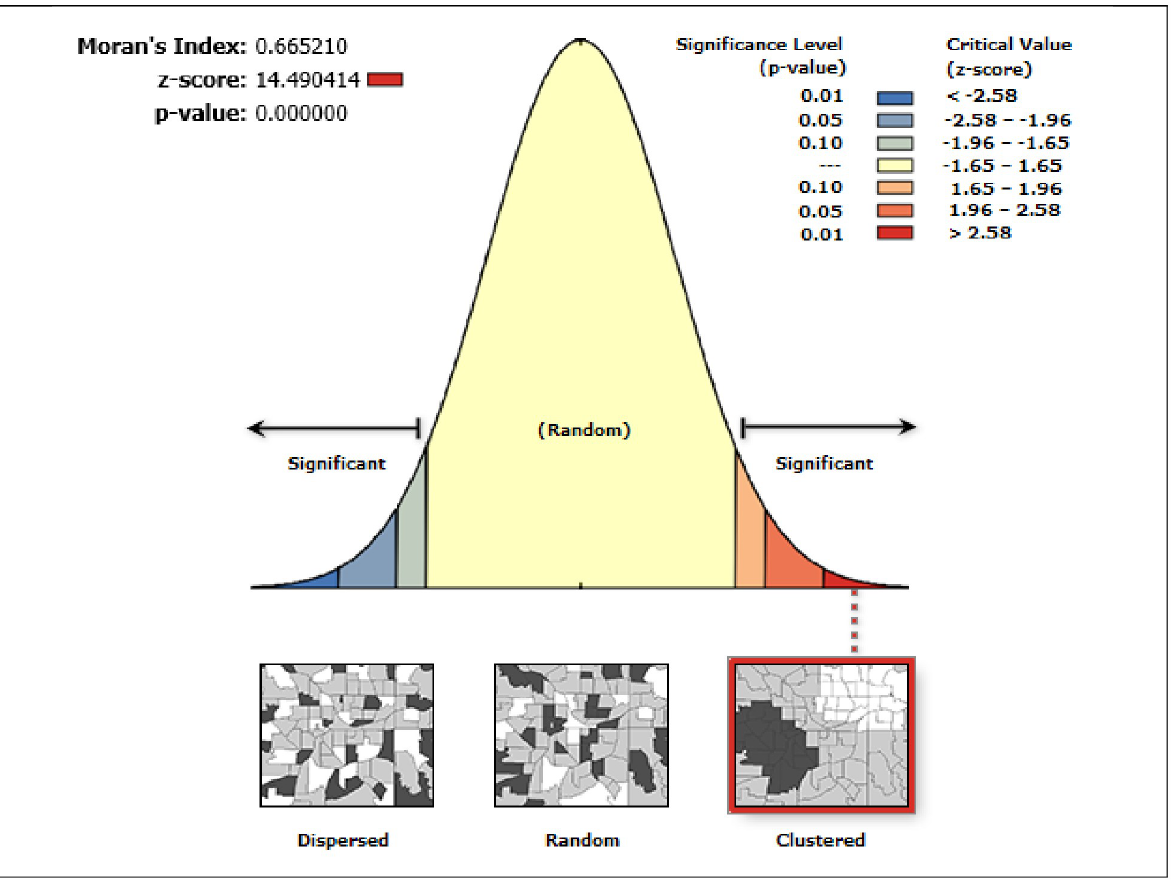
Fig 2. Spatial autocorrelation of home delivery in Ethiopia;